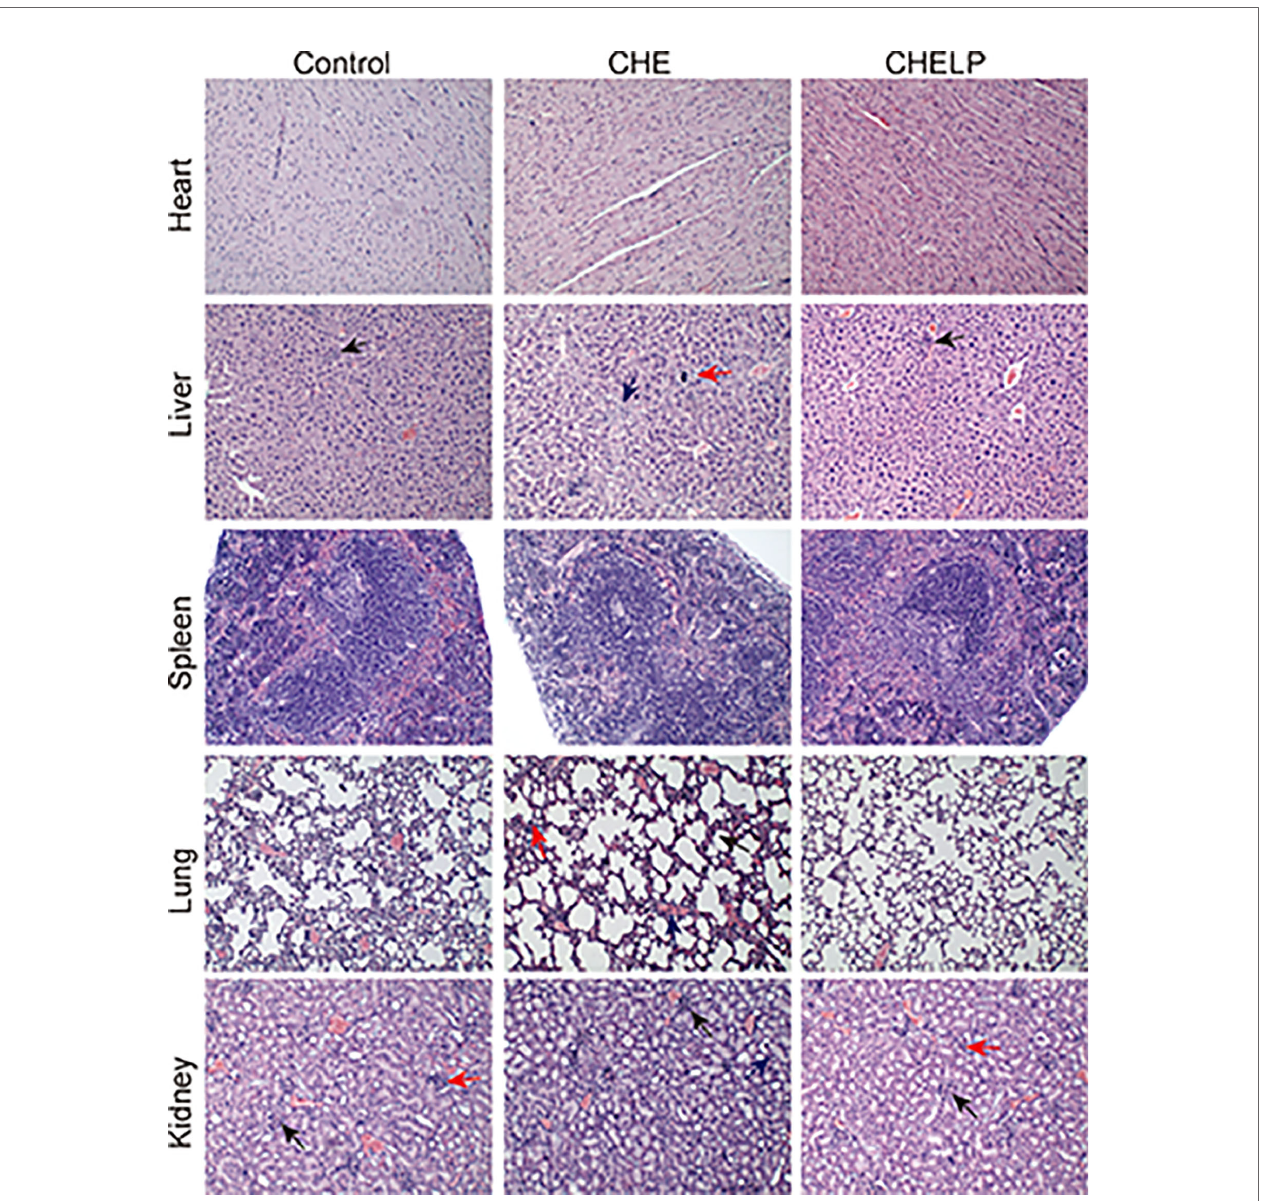
FIGURE 10 | Pathological evaluation. (1) Liver, a small amount of in fl ammatory cells in fi ltrate ( ↑ ); (2) Lung, alveolar septa slightly thickened ( ↑ ), in fl ammatory cell proliferation ( ↑ ), slight congestion in the blood vessels ( ↑ ); (3) Kidney, the renal microcysts become smaller or disappear ( ↑ ), glomerular atrophy ( ↑ ), the renal tubules are marked by clear tubules ( ↑